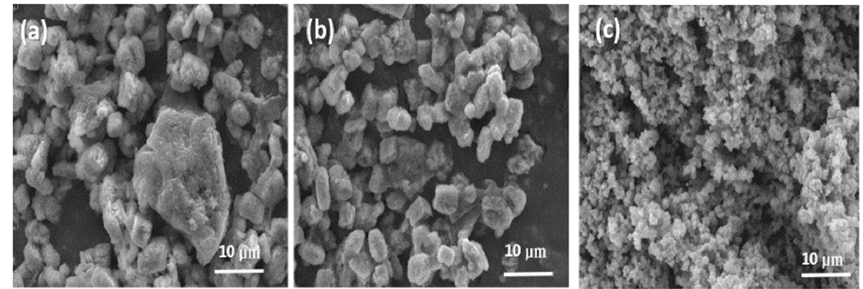
Figure 2. SEM images of ( a ) WS 2 , ( b ) WSe 2 , and ( c ) WSSe-3.